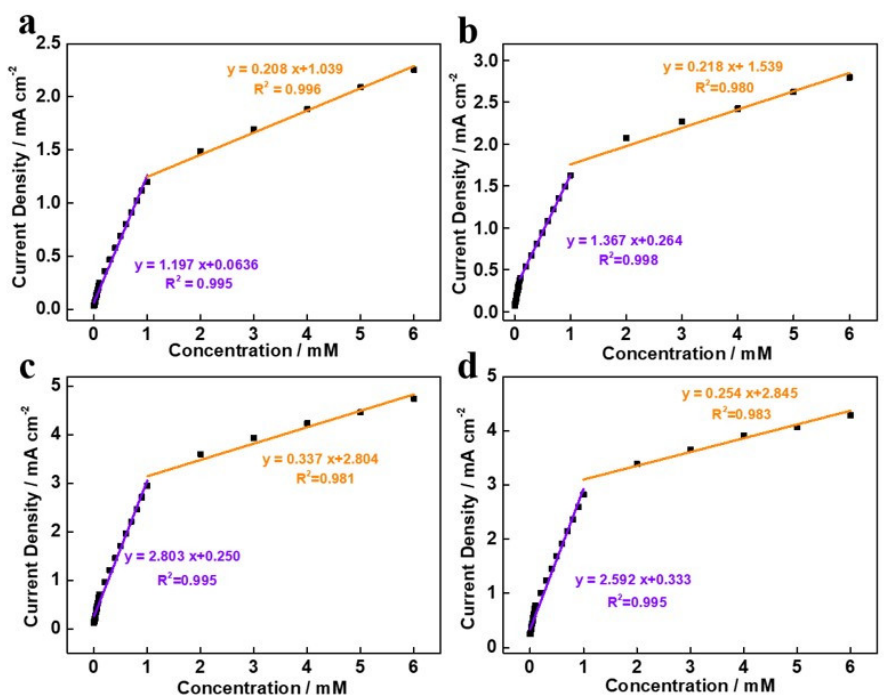
Figure 7. The corresponding calibration curves of different samples: ( a ) NiCo 2 O 4 -NC, ( b ) Ag/NiCo 2 O 4 -NC-30, ( c ) Ag/NiCo 2 O 4 -NC-60 and ( d ) Ag/NiCo 2 O 4 -NC-90.